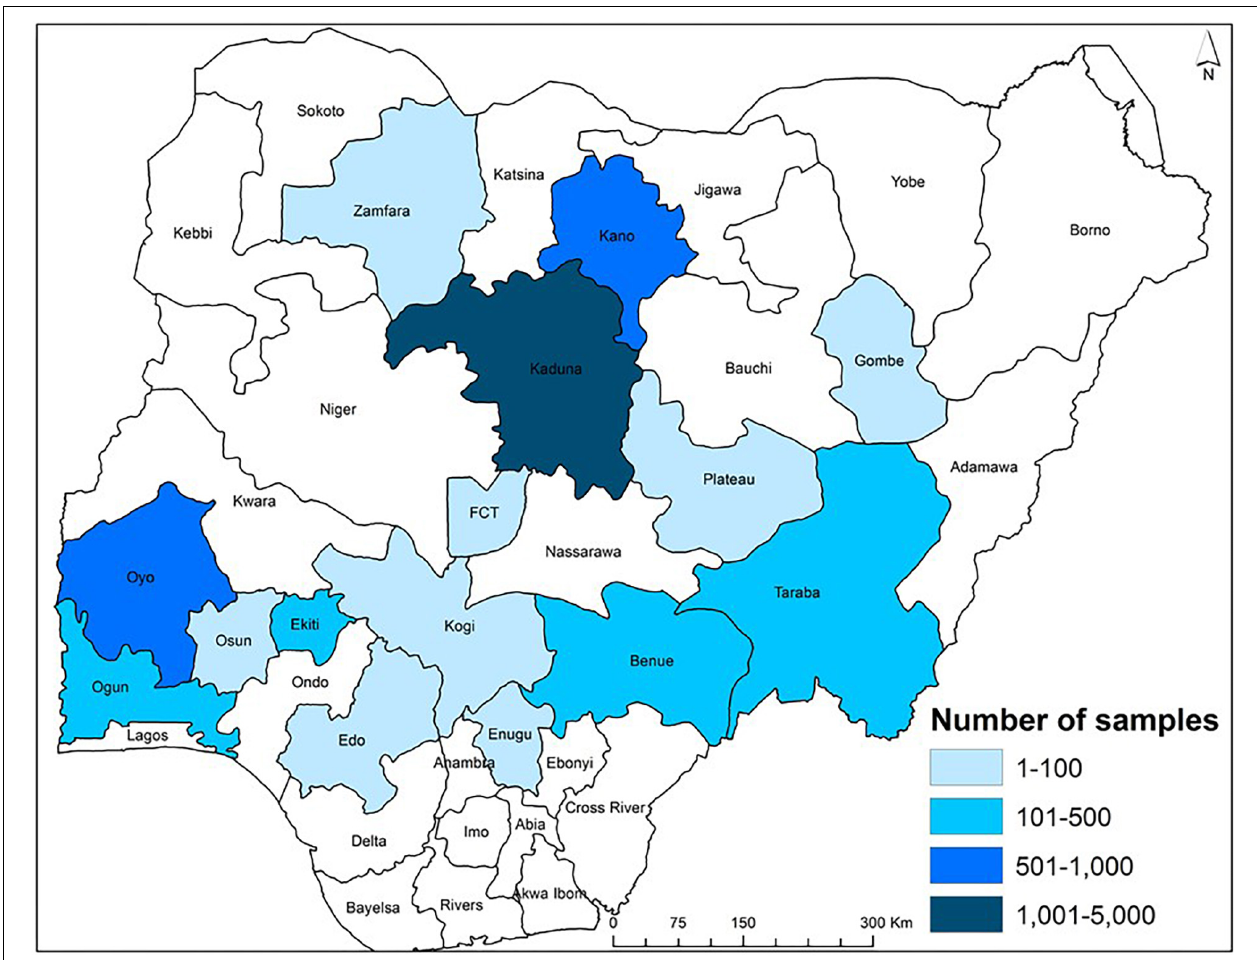
FIGURE 3 | Map of Nigeria showing the range in the number of maize samples collected from aggregation points in various states during 2013 to 2018. Each sample represents approximately a 30-ton grain lot aggregated from farmers who used an atoxigenic biocontrol product on a commercial